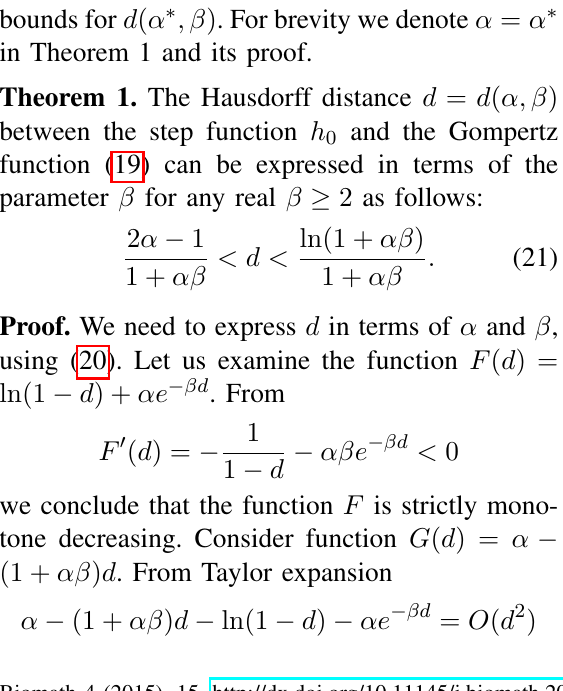
B OUNDS FOR d ( α ∗ , β ) COMPUTED BY (20) FOR VARIOUS β